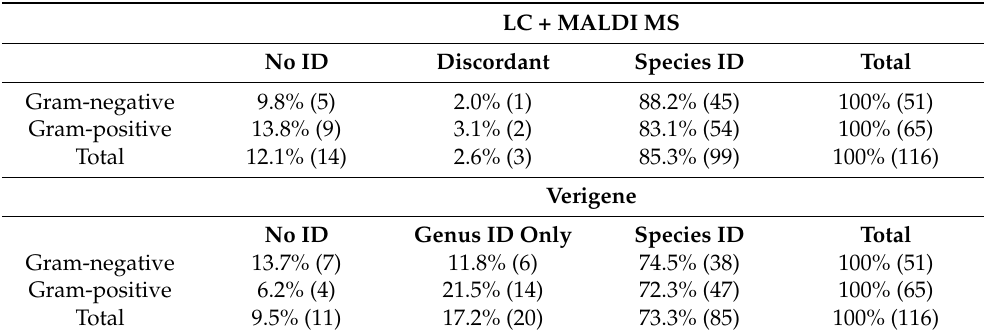
Table 2. Identification for Liquid Colony Plus MALDI MS vs. Verigene in prospective specimens.